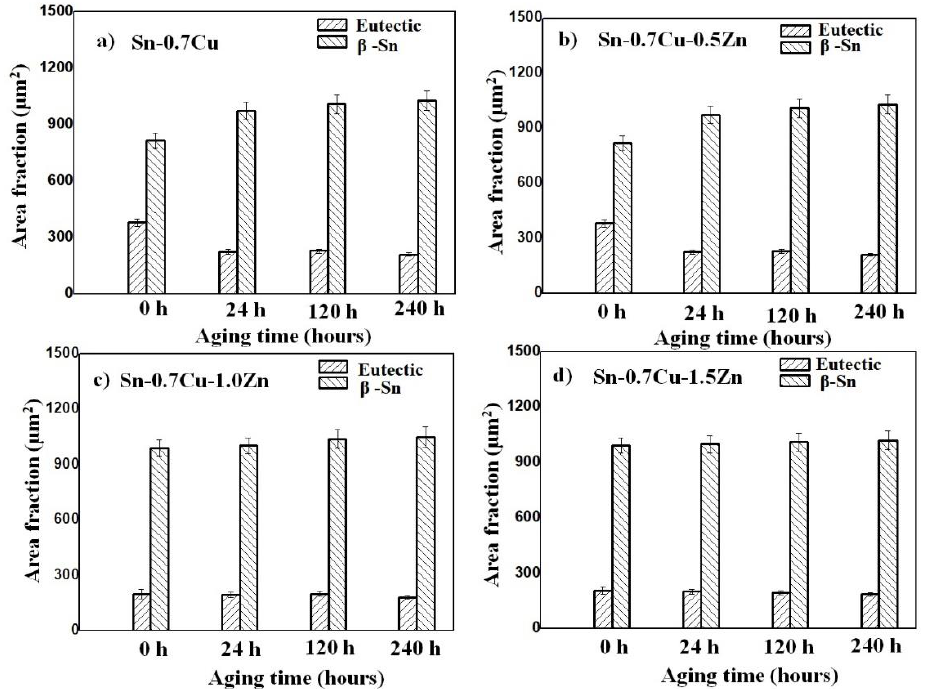
Figure 5. Area fraction of ( a ) Sn-0.7Cu, ( b ) Sn-0.7Cu-0.5Zn, ( c ) Sn-0.7Cu-1.0Zn and ( d ) Sn-0.7Cu-1.5Zn at various annealing time.